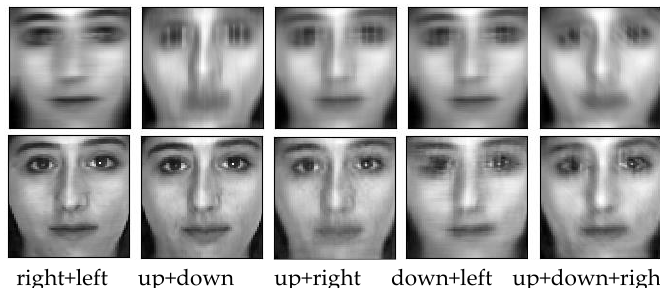
Figure 5. Restored images for input images with motion blur in different directions.